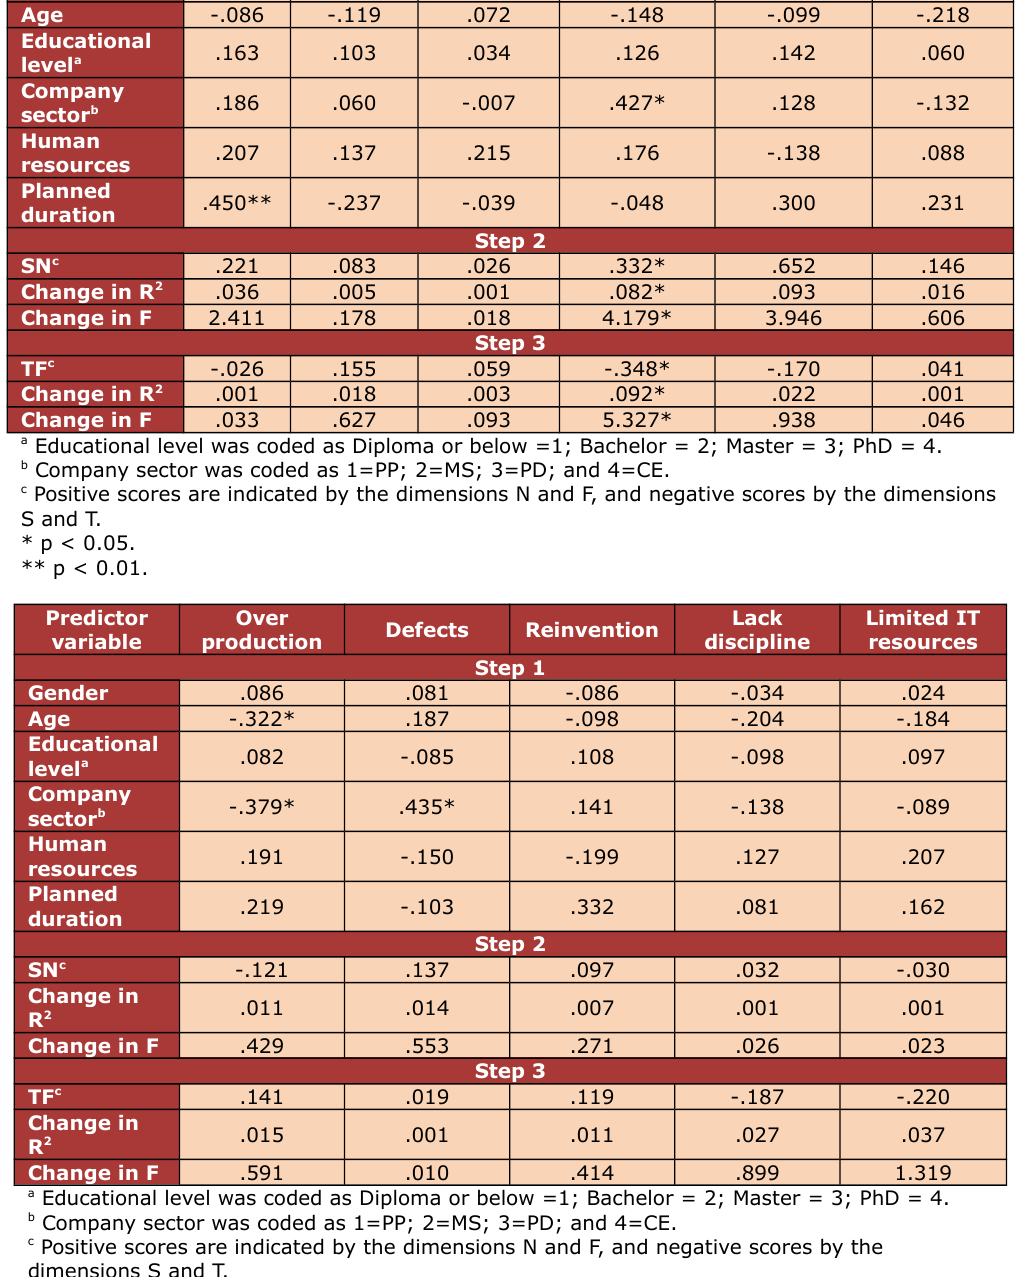
Table 9. Effect of SN and TF on VSM performance